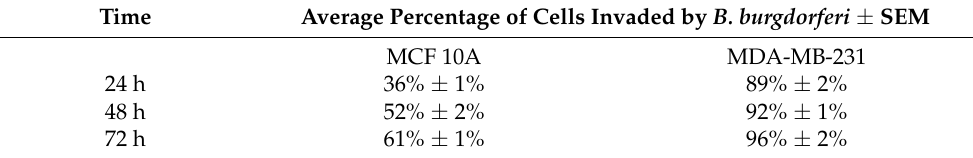
Table 1. Quantitative analysis of the number of the different mammary epithelial cell lines invaded by B. burgdorferi at different time intervals.